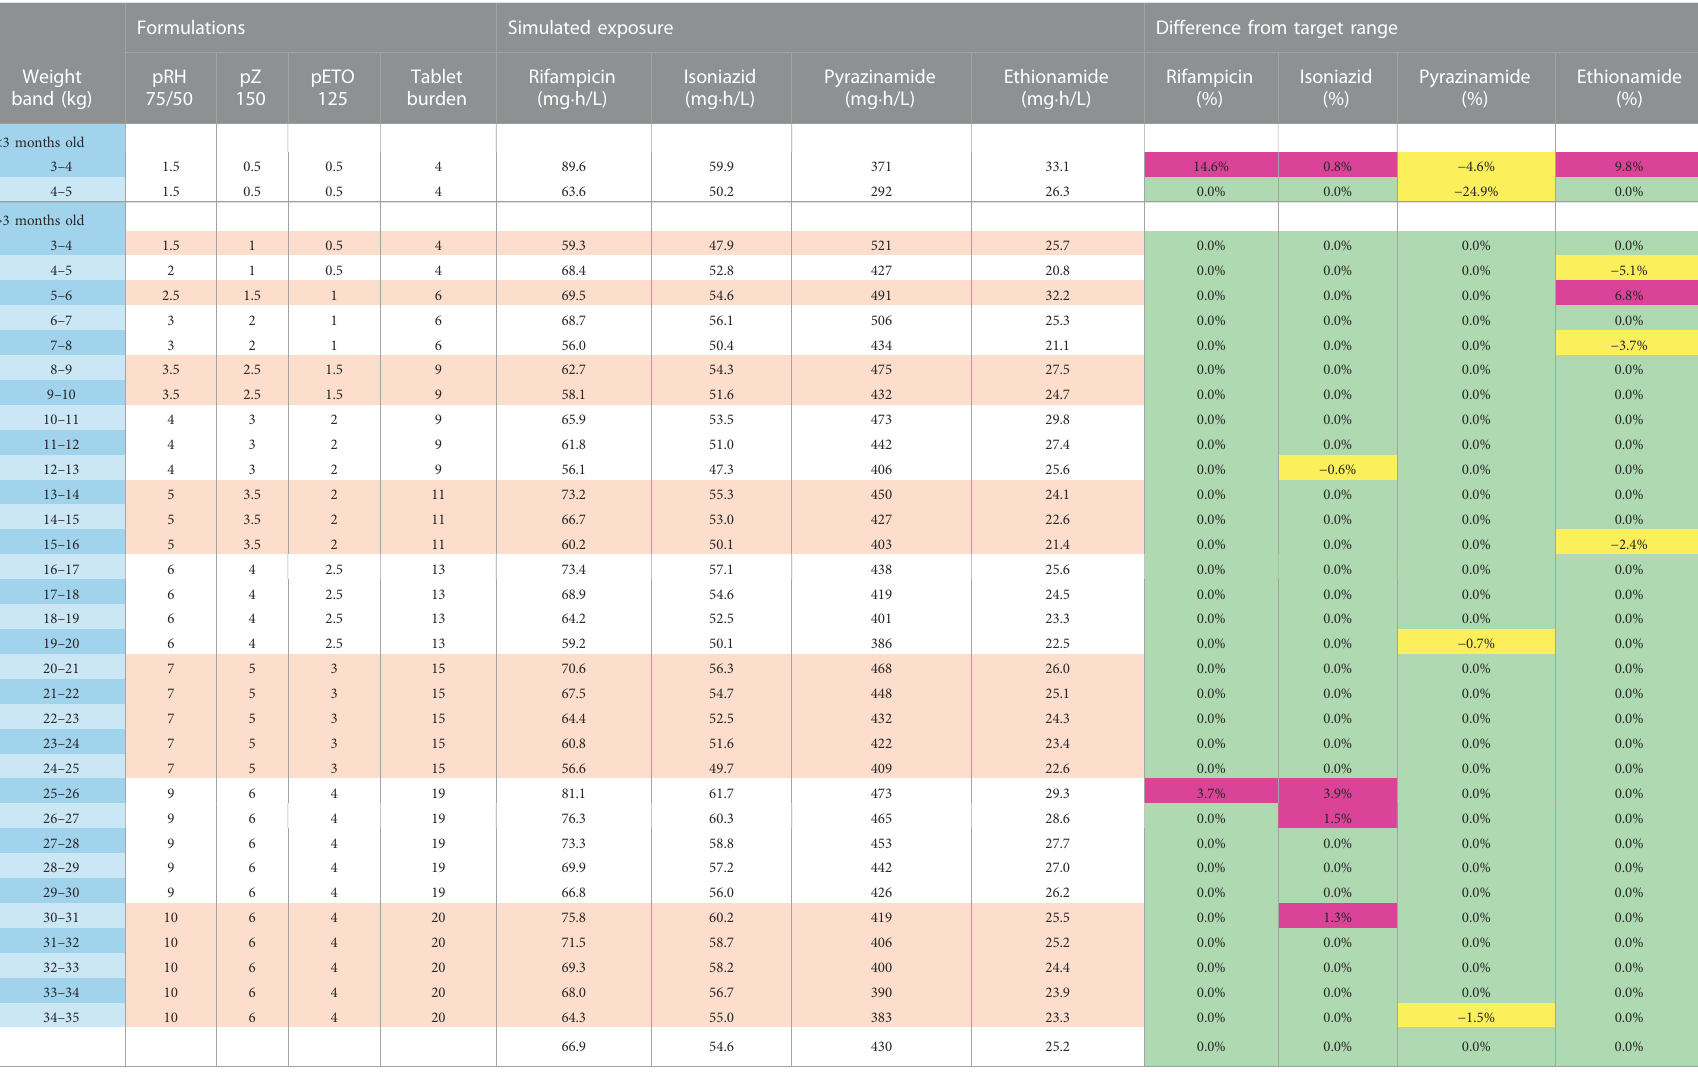
TABLE 2Dosing table usingchild-friendly formulations for children from 3to35 kg.The red andwhite horizontal bands inthe formulation ’ s column represent the weight bands receiving the same dose. The colours inthe last columns show if exposures are expected to be within (green) or outside the target range where yellow represents the percentage below the lower bound of the target range and purple represents the percentage above